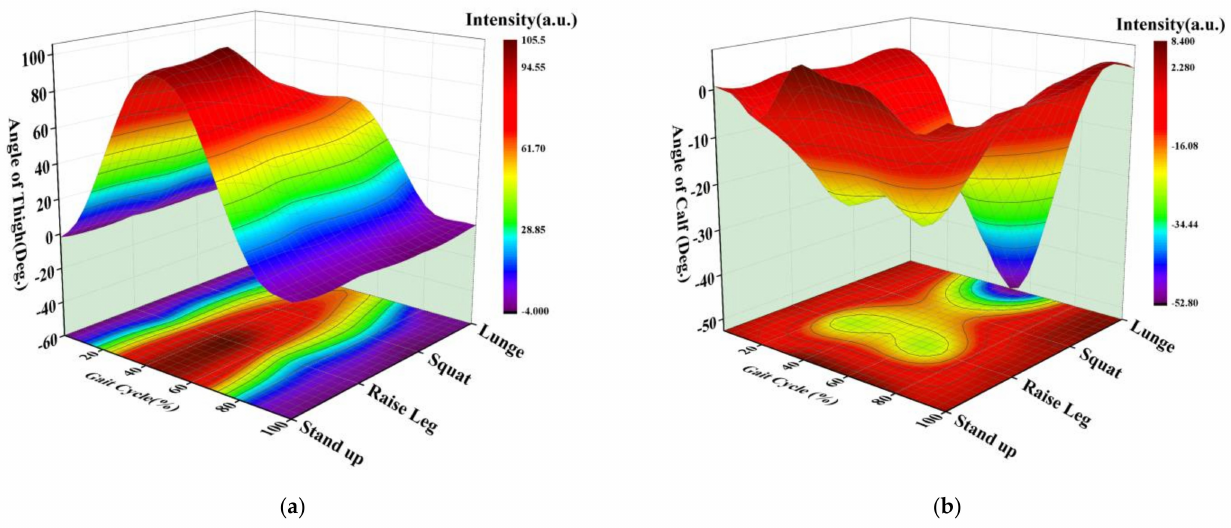
Figure 16. Changes of lower limb angle in 4 movements. ( a ) Thigh angle; ( b ) calf angle. It is required that the subject completes the specified action within 2 s and repeats it after 2 s. Therefore, a total of 15 motion cycles were collected in the sampling period of 60 s. The results are shown in Figure 17a–d. The EMG signals of each muscle of the lower limbs during each action suggest good periodicity, and the active state and the resting state of the signals have a good distinction. The same muscle shows different EMG signal waveforms during different actions. When squatting, the EMG signal of the gastrocnemius muscle is weak, when lunging, the rectus femoris muscle has a strong signal in the resting state, which leads to the weak periodicity of the signal. The signal amplitude of the tibialis anterior muscle and gastrocnemius muscle on the calf was smaller when raising the leg and standing up. This is because these two movements are mainly completed via the active movement of the thigh [22]. As seen in Figure 17b, there is no certain regularity in the angle change of the calf during the two